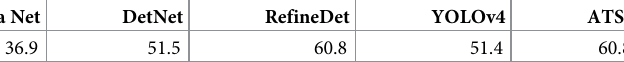
Table 4. Result for training on KUMC and testing on the full combined test set. Faster